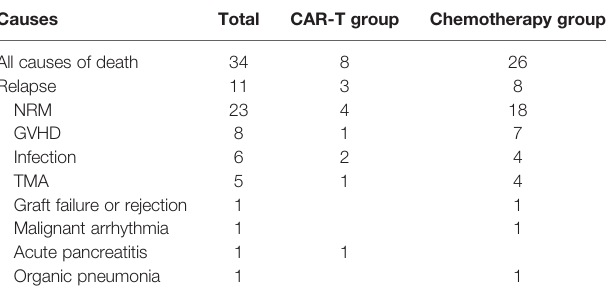
TABLE 3 | Causes of death in the CAR-T and chemotherapy